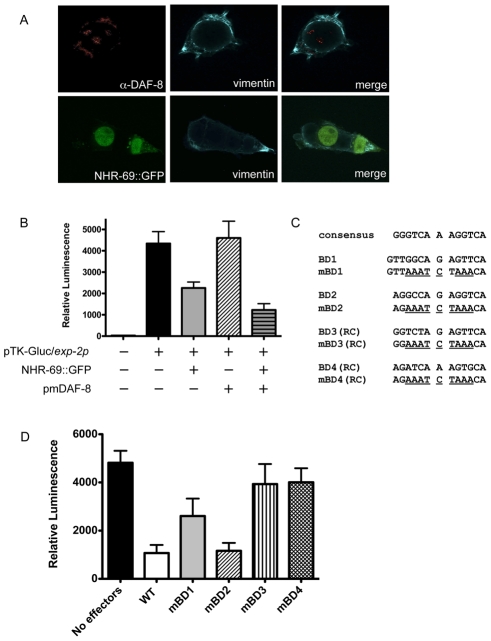
NHR-69 and DAF-8 suppress exp-2 promoter activity in mammalian cells.(A) Plasmids expressing NHR-69::GFP and a phosphomimetic variant of DAF-8 (pmDAF-8) were transiently transfected into HEK293 cells and visualized by fluorescence imaging; both proteins show nuclear localization. (B) The bar graphs depict relative luciferase activity resulting from a transiently transfected exp-2-driven luciferase reporter in HEK293 cells. NHR-69, but not pmDAF-8 single transfection represses the exp-2 promoter, and cotransfection of NHR-69 and pmDAF-8 causes an even stronger repression. (C) Details on the site-directed mutagenesis of HNF4α-like binding sites in the exp-2 promoter. (D) The graph depicts the consequence of site directed mutagenesis of HNF4α-like binding sites in the exp-2 promoter on luciferase activity. “No effectors” indicates transfection of the reporter alone, whereas “WT” indicates co-transfection of NHR-69 and pmDAF-8 with the wild-type exp-2 promoter (similar to panel B). Mutating BD1, BD3, or BD4 attenuates the NHR-69 and pmDAF-8-mediated repression of exp-2 activity. The result is an average from three individual trials.